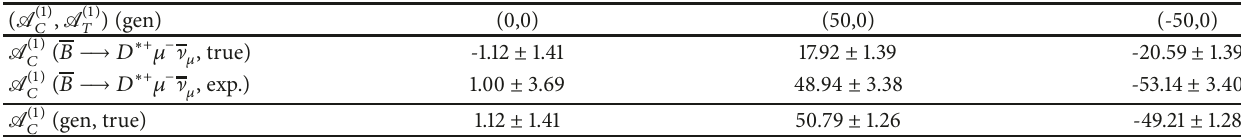
Table 5: Measured A (1) 𝐶 (in%) fitting the angular distribution equation (10)or the polynomial expansions equation (20) to the 𝐵 󳨀→ 𝐷 ∗+ 𝜇 − ] 𝜇 test sample for varying generated values; the last row reports the ideal sensitivity obtained from a toy sample generated from the true angular distribution with the same number of events of the test sample, fitted with the same distribution.